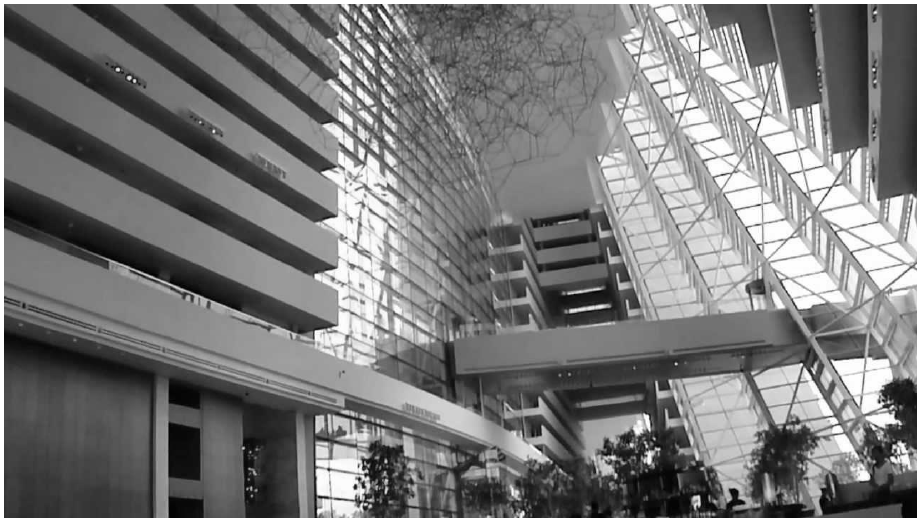
Figure 7. Atrium in the Marina Bay Sands Hotel (Singapore, photograph by authors).